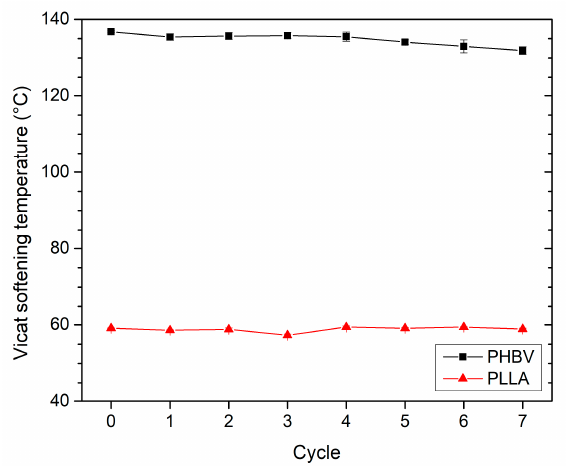
Figure 13. PLLA and PHBV Vicat softening temperature as a function of recycled